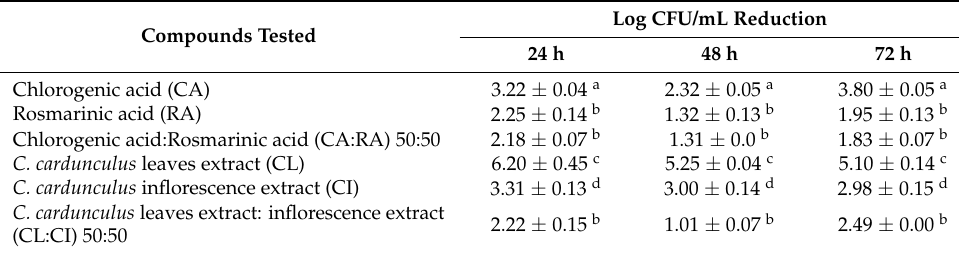
Table 3. Influence of C. cardunculus decoction extracts and standard compounds in P. putida ESACB 191 growth reduction (Log CFU/mL), over the incubation time (24, 48 and 72 h). Different superscript letters in the same line, correspond to statistically different values ( p ≤ 0.05). Log CFU/mL Reduction Compounds Tested 24 h 48 h 72 h Chlorogenic acid (CA) 3.22 ± 0.04 a 2.32 ± 0.05